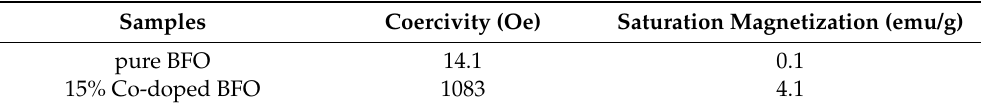
Table 1. Magnetic parameters for the pure and 15% Co-doped BFO powders thermally treated at 700 ◦ C for 30